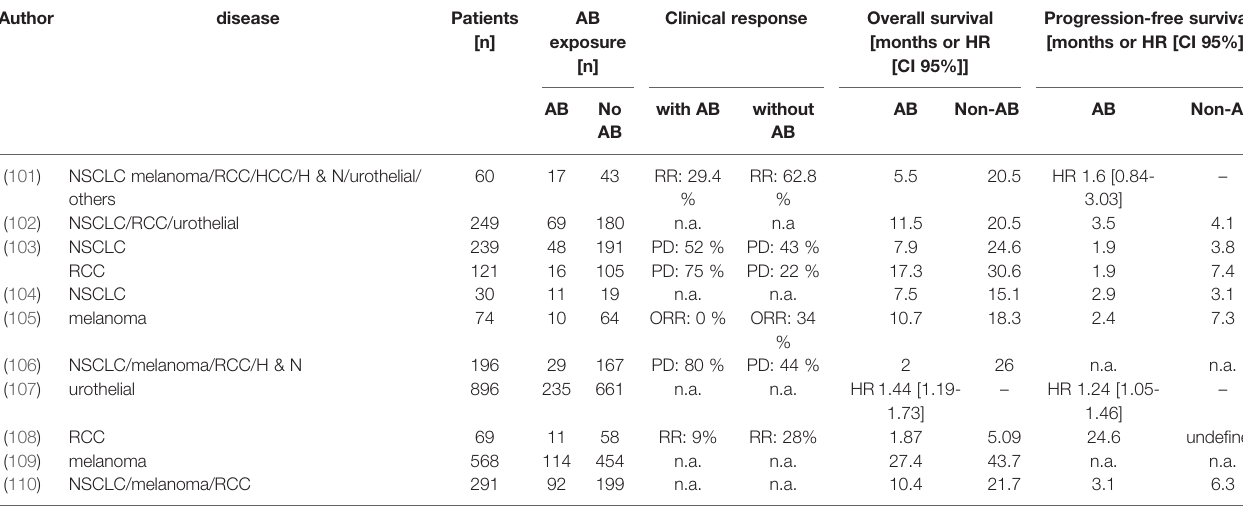
TABLE 1 | Outcome of patients treated with immune checkpoint inhibitors (ICI) with or without receiving antibiotic (AB) treatment.